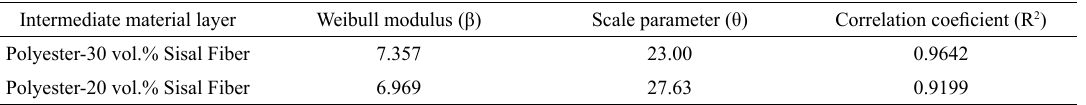
Table 3. Weibull statistical parameters for ballistic tests with MAS having different second layers Intermediate material layer